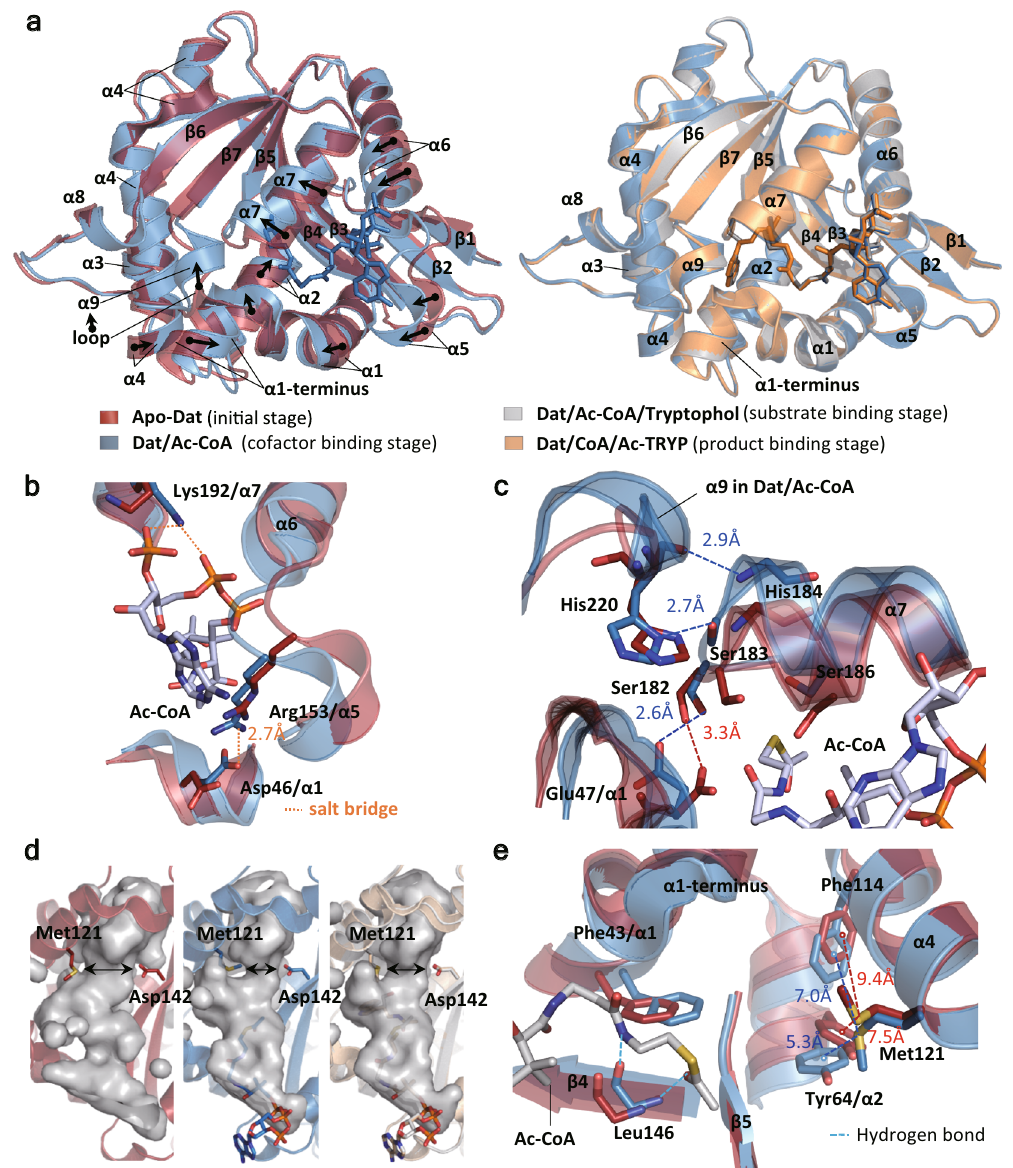
Fig. 3 Conformational comparison in different stages of catalysis. a Overall structural comparison of Dat. Left, superimposition of apo-Dat (red, PDB code: 3V8I) and Dat/Ac-CoA complex (blue, PDB code: 3TE4); right, superimposition of Dat/Ac-CoA complex (blue, PDB code: 3TE4), Dat/Ac-CoA/ tryptophol complex (gray, PDB code: 6K80), and Dat/CoA/Ac-TRYP complex (orange, PDB code: 5GI9). Conformational changes are shown by arrows. b Cofactor-binding pocket showed an open-to-closed form conversion from apo-Dat (red) to Dat/Ac-CoA complex (blue), forming salt bridges in α 1/ α 5/ α 7 region. c Superimposition of apo-Dat (red) and Dat/Ac-CoA complex (blue) focusing on catalytic site. Two hydrogen bonds between α 7 and α 9 were established by His220, Ser183, and His184 after Ac-CoA binding. The orientations of catalytic residues, Glu47, Ser182, and Ser186 also changed. d The reaction tunnels in the apo-Dat, binary complex, and two ternary complexes are shown in gray. A bottleneck surrounded by Met121 and Asp142 was formed after Ac-CoA binding. e Superimposition of apo-Dat (red) and Dat/Ac-CoA complex (blue) focusing on aromatic residues of the substrate-binding pocket. Residues, substrates, and cofactors are shown as sticks. Distances, salt-bridge interactions, hydrogen bonds, and Met-aromatic interactions are shown by dashed